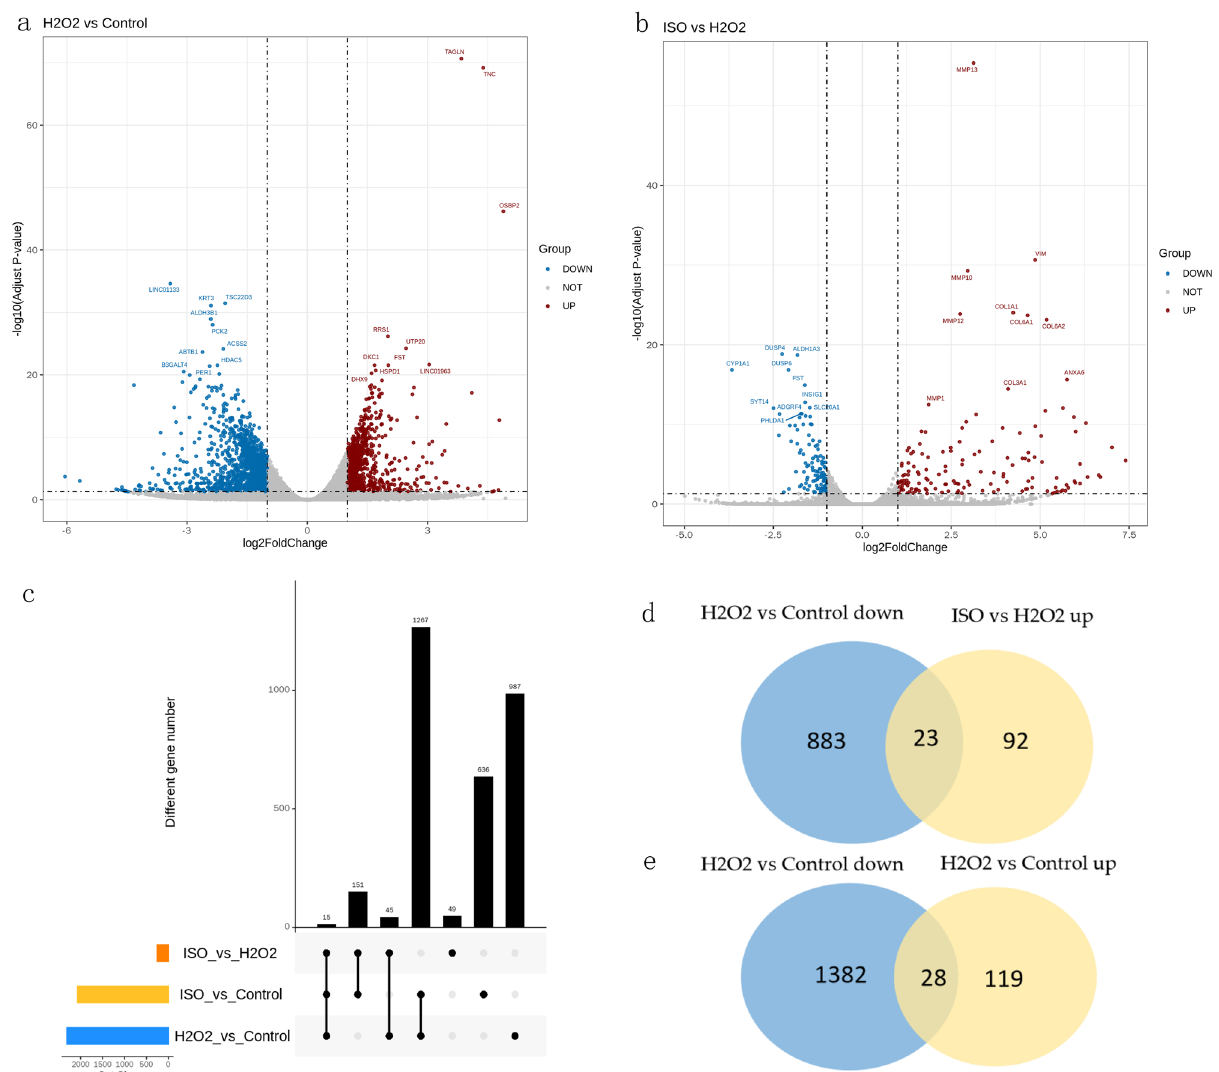
Figure 3. Differentially expressed genes (DEGs). ( a , b ) Volcano plot of gene expression profiles in the ( a ) control vs. H 2 O 2 and ( b ) ISO vs. H 2 O 2 comparisons. ( c – e ) Venn diagrams showing ( c ) unique or shared DEGs for those ( d ) upregulated in H 2 O 2 vs. control and downregulated in H 2 O 2 + ISO and genes that are ( e ) downregulated in H 2 O 2 vs. control and upregulated in H 2 O 2 + ISO. H 2 O 2 hydrogen peroxide, ISO isorhamnetin, control group untreated HaCaT cells, H 2 O 2 group HaCaT cells treated with 600 μM H 2 O 2 for 12 h, ISO group 600 μM H 2 O 2 + 40 μM